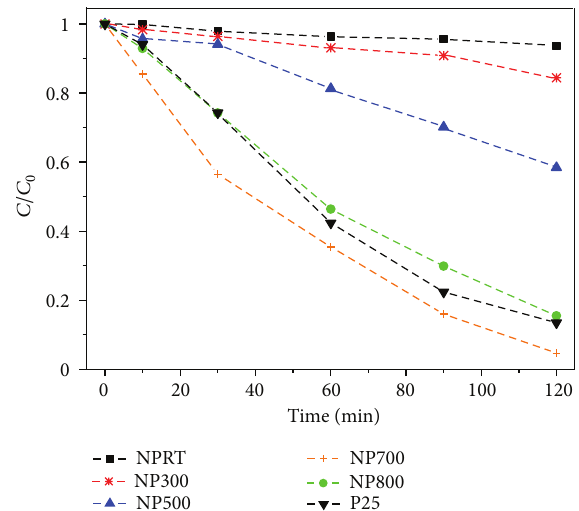
Figure 3: UV-vis absorption variation at 665 nm measured in the dark of MB (10 −5 M, pH 7.2) solution as a function of time for nano- TiO 2 powders annealed at different temperatures. This experiment has also been performed for the P25 reference powder.